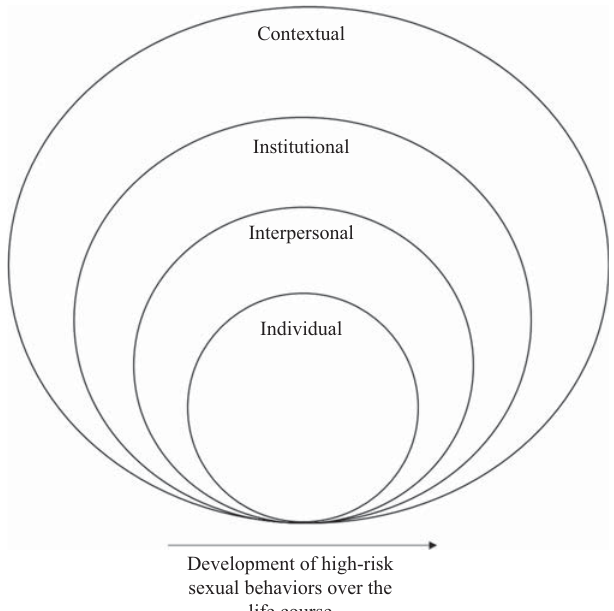
Figure 1. Conceptual map used to develop interview